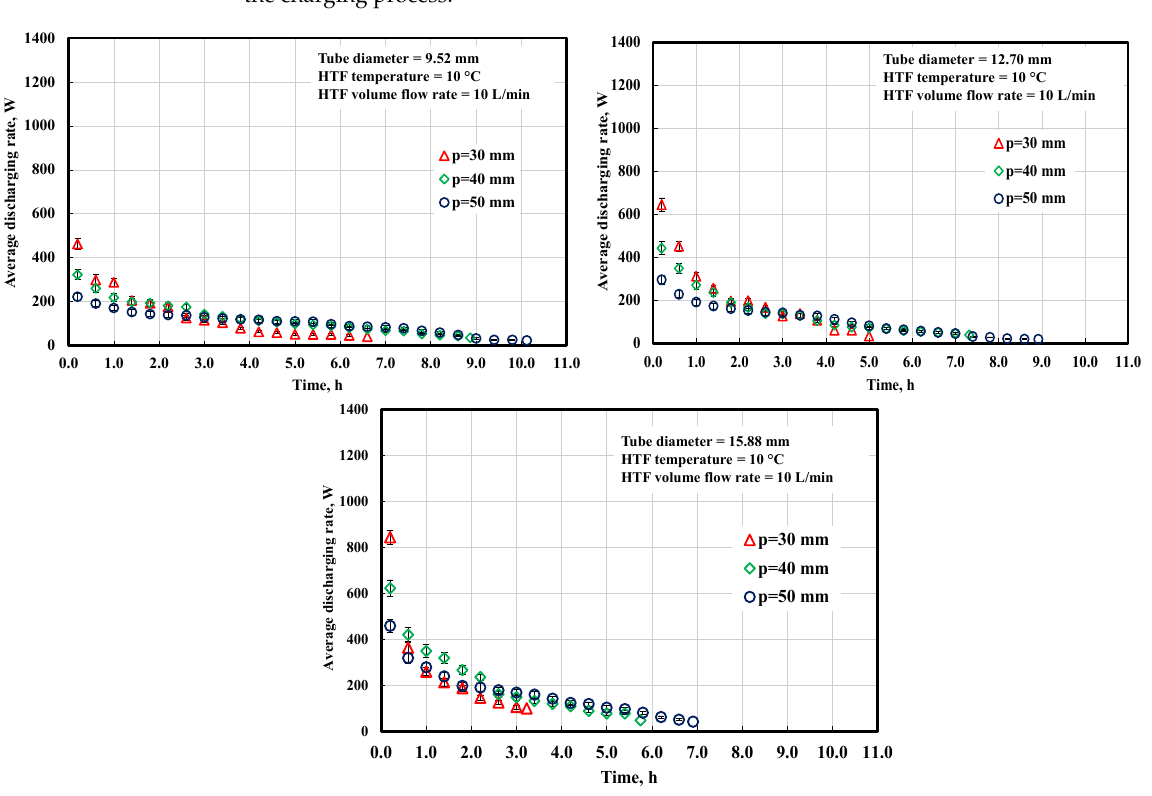
Figure 6. Average discharging rate with time for different coil pitches with coil tube diameters during the discharging process.